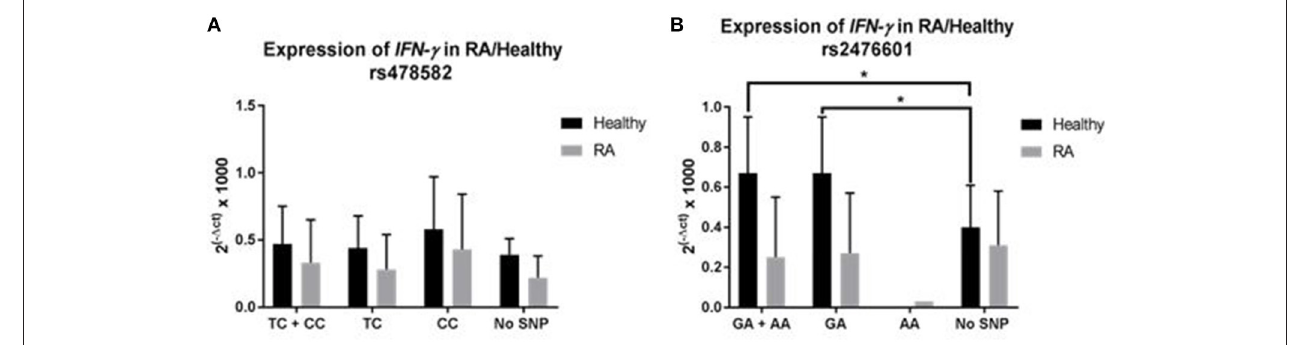
FIGURE 5 | Effect of PTPN2:rs478582 / PTPN22:rs2476601 on IFN- γ Expression in RA. (A) IFN- γ expression in RA and healthy control subjects with PTPN2:rs478582 . (B) IFN- γ expression in RA and healthy control subjects with PTPN22:rs2476601 . * P -values ≤